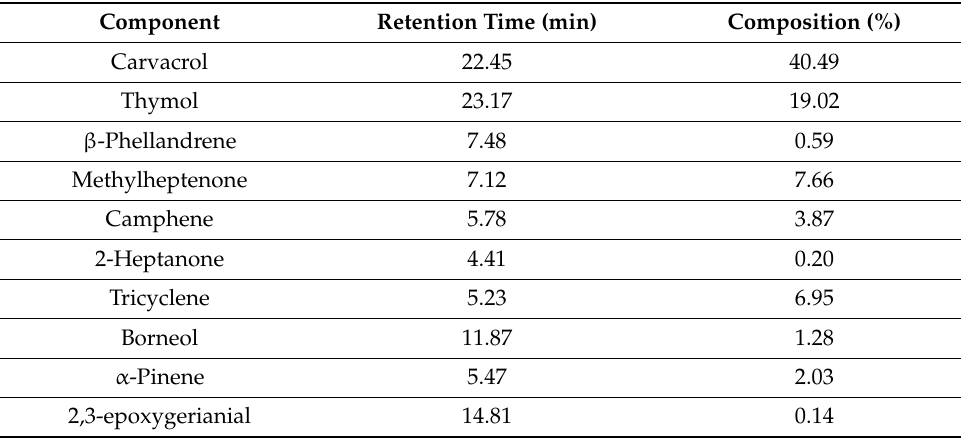
Table 4. Identification of Zingiber officinale aqueous extract bioactive